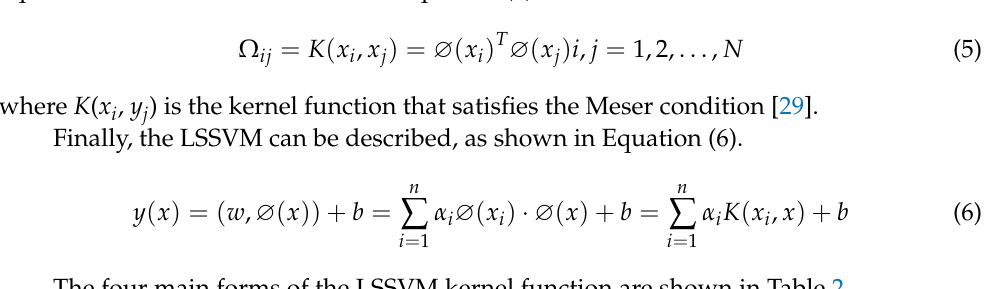
Table 2. The forms of the kernel function. Kernel Function Forms The polynomial kernel function K (cid:4666) x, 𝑥 The radial basis kernel function The sigmoid kernel function The linear kernel function k (cid:4666) x, 𝑥